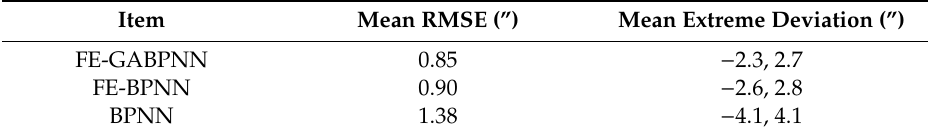
Table 1. Comparative result by Fourier expansion-BP neural network optimized by genetic algorithm (FE-GABPNN), Fourier expansion-standard BP neural network (FE-BPNN) and standard BP neural network (BPNN).